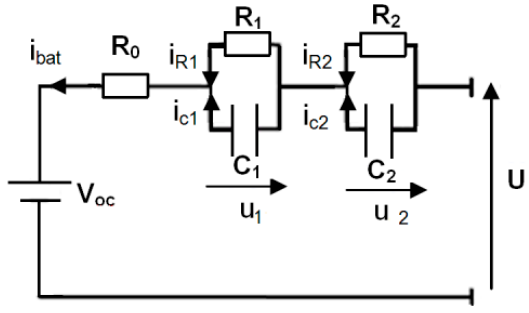
Figure 1. Thevenin equivalent circuit.